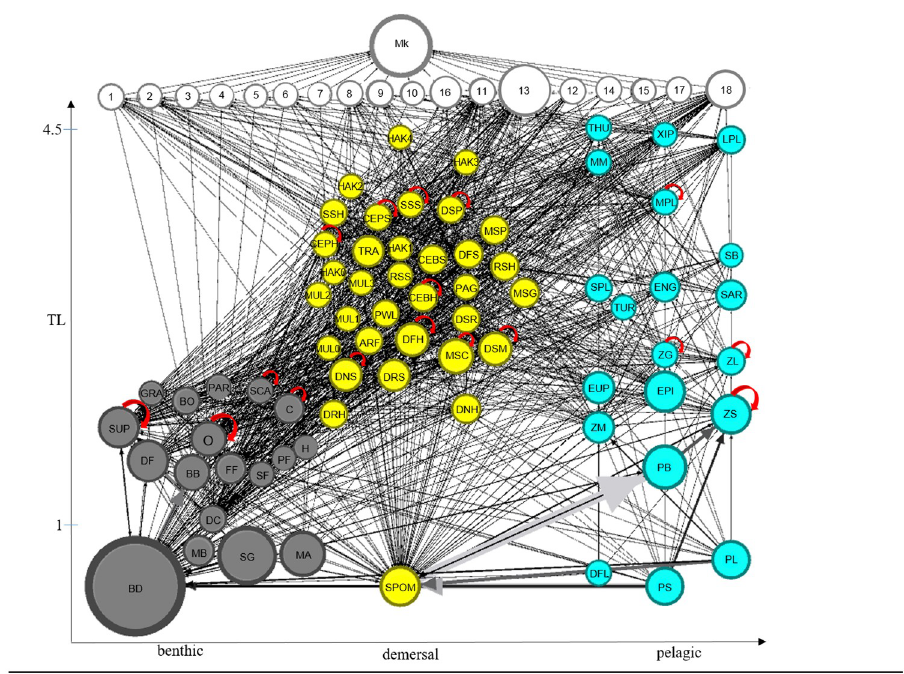
Fig 3. Flow diagram of the food web. Functional groups (nodes) by trophic levels (TL, y-axis) and by benthic (gray), demersal (yellow) and pelagic (cyan) domains (x-axis). White nodes represent fishing activities and the market (Mk). Links width are proportional to flow intensity, i.e., to annual food consumption rates for FG ( > 5^ -6 t km − 2 year − 1 ), to catches for fleets and to landings for the market. Node radius is proportional to the square root of FG biomass, total catch of fleets and total landings for the market. Gray arrows indicate higher fluxes. Red arrows are loops (cannibalism).